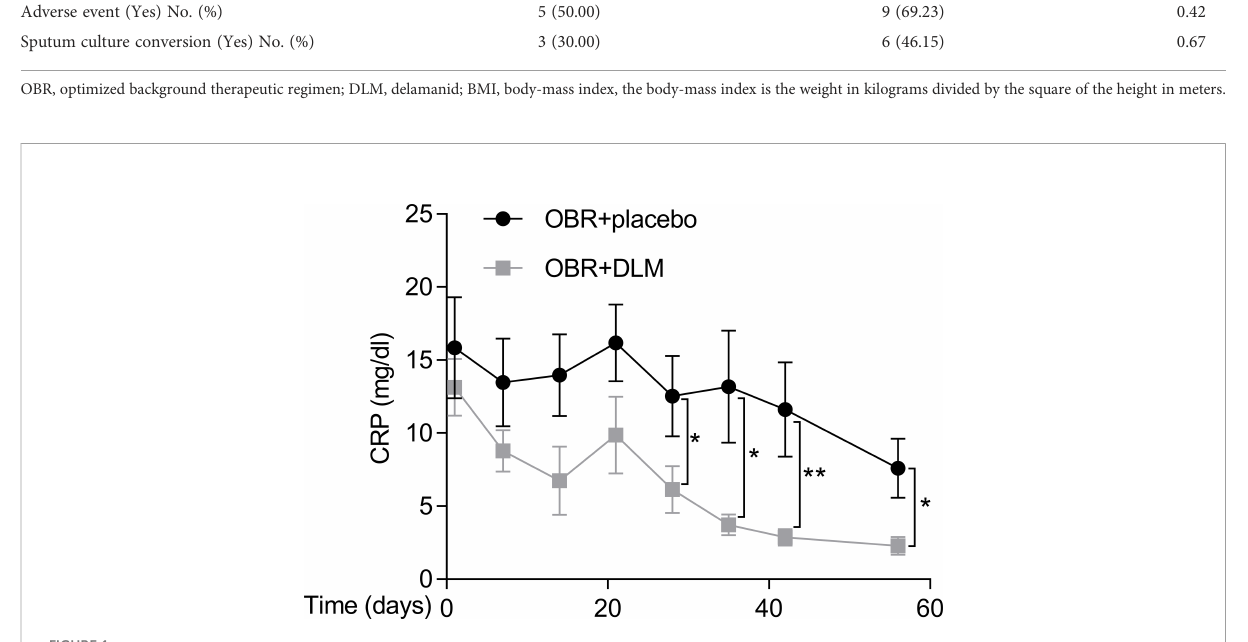
FIGURE 1 Dynamic changes in C-reactive protein level of MDR-TB patients within 8 weeks after treatment. The levels of CRP in two group patients. Data are presented as mean ± SEM. * p <.05, ** p <.01 (t